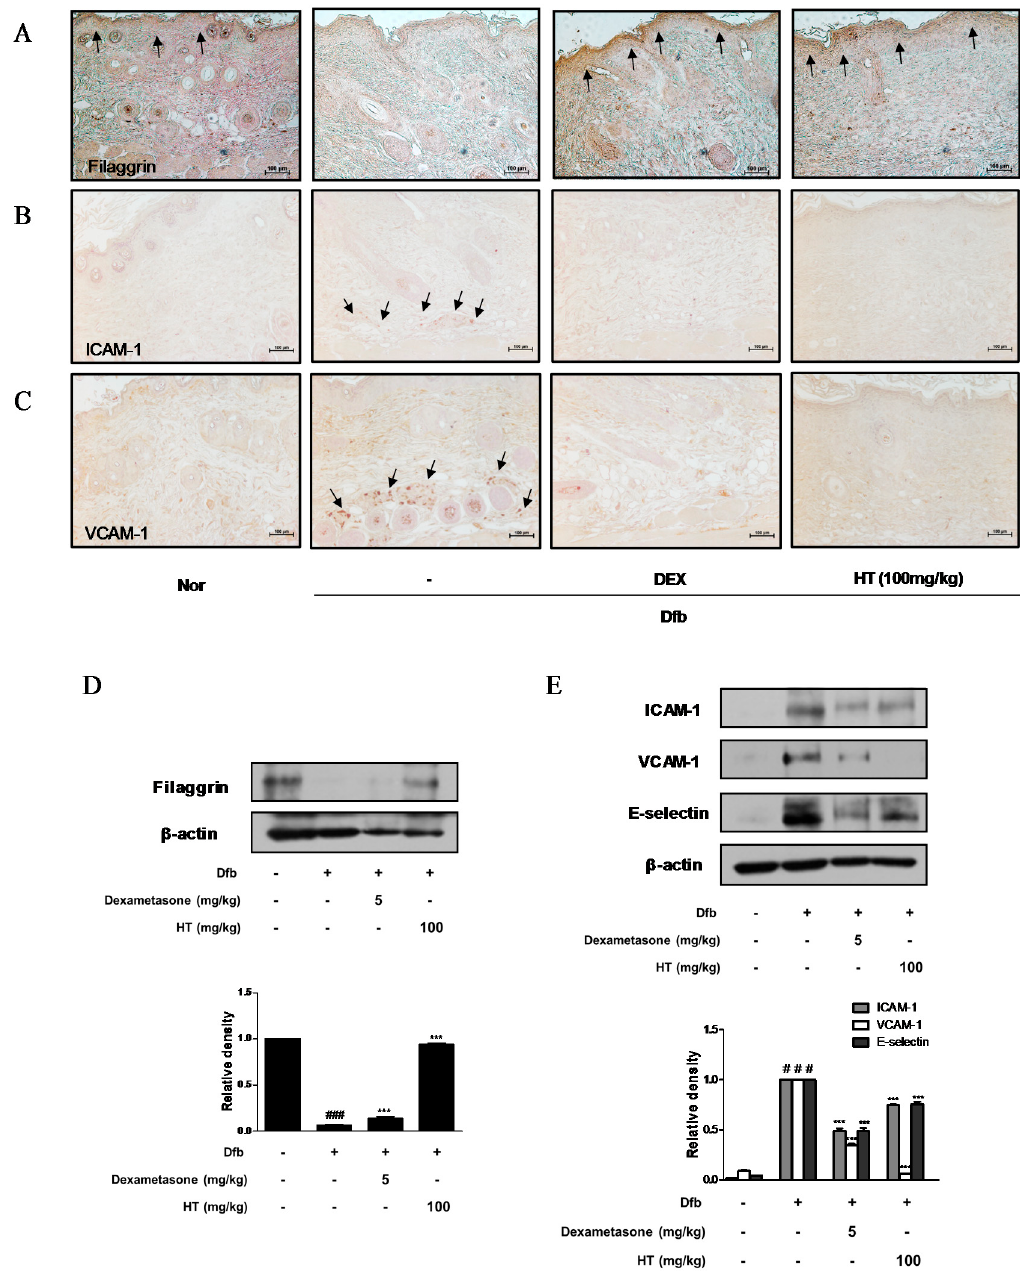
Figure 4. Effects of HT on expression of adhesion molecules and filaggrin in Dfb-induced NC/Nga mice. Skin sections were stained with immunohistochemical staining. Dexamethasone (5 mg/kg, DEX) was used as a positive control. ( A ) Filaggrin, ( B ) ICAM-1, and ( C ) VCAM-1 in the mouse skin were detected using specific antibodies. Black arrows indicated stained (scale bar = 100 µ m). Total proteins were prepared and western blotted for ( D ) filaggrin, and ( E ) adhesion molecules using specific antibodies. β -actin was used as internal control. The data shown represent mean ± S.D. of three independent experiments. # p < 0.05, ### p < 0.001 vs. the control group; *** p < 0.001 vs. Dfb-treated group.